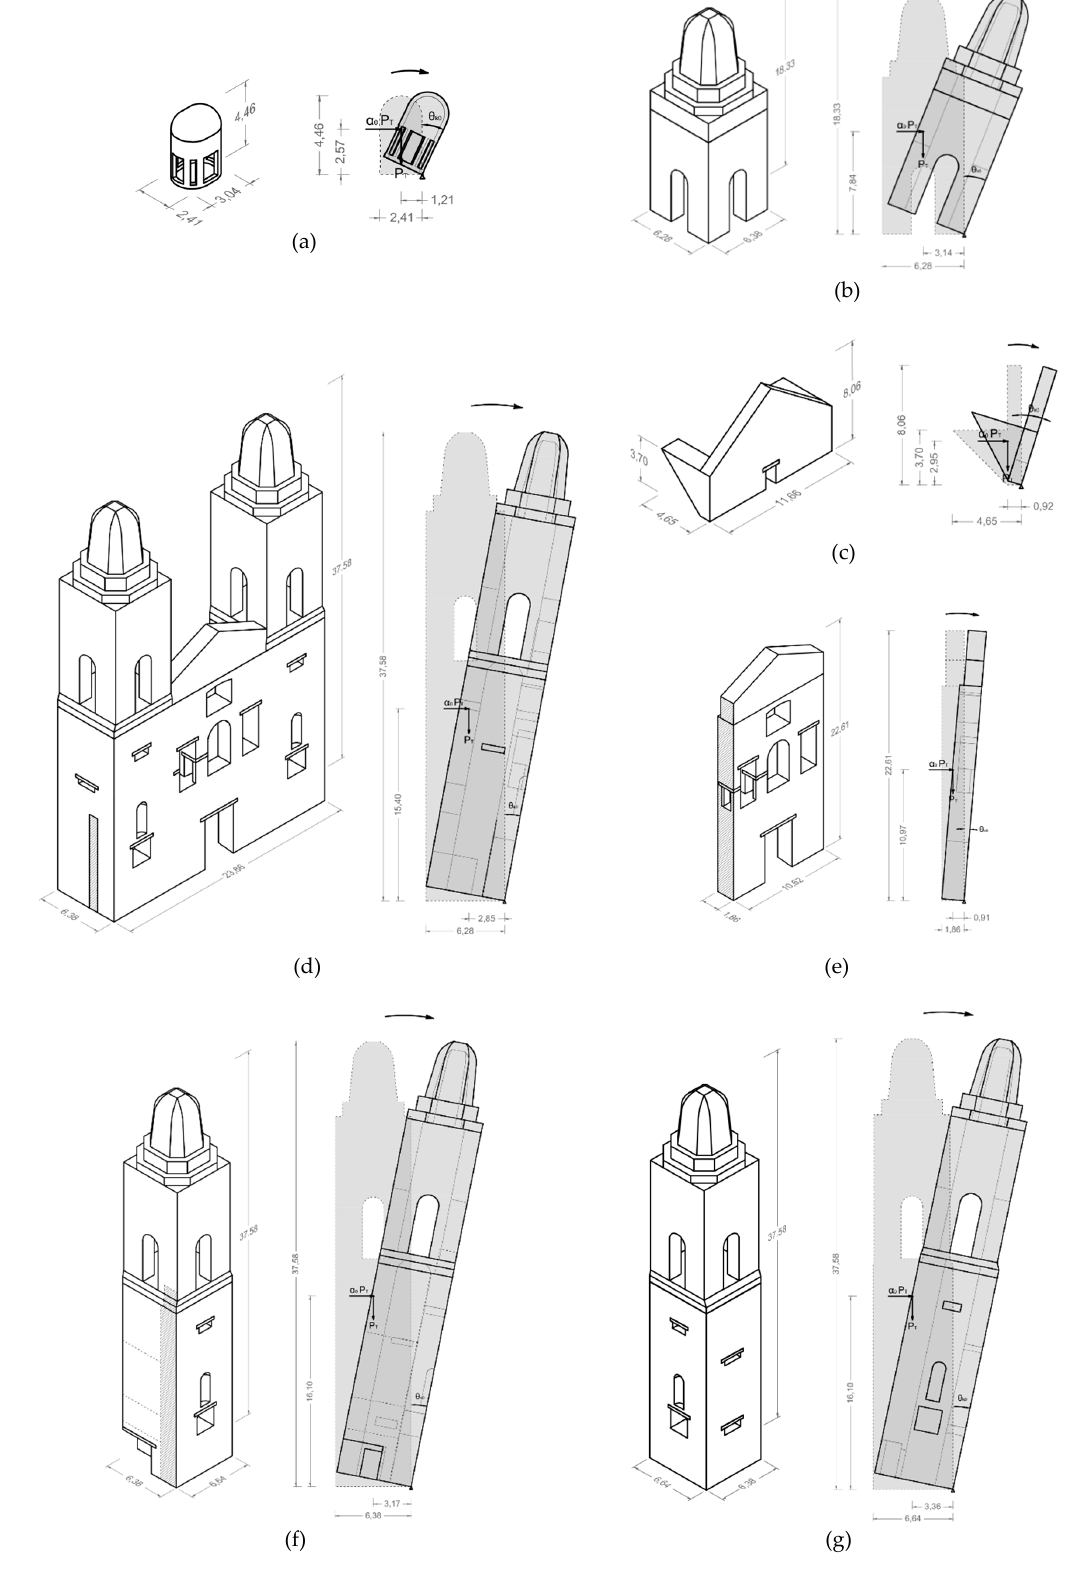
Figure 14. Collapse mechanisms considered for limit analysis: ( a ) Mechanism 1, ( b ) Mechanism 2, ( c ) Mechanism 3, ( d ) Mechanism 4, ( e ) Mechanism 5, ( f ) Mechanism 6, ( g ) Mechanism 7. Units in m.